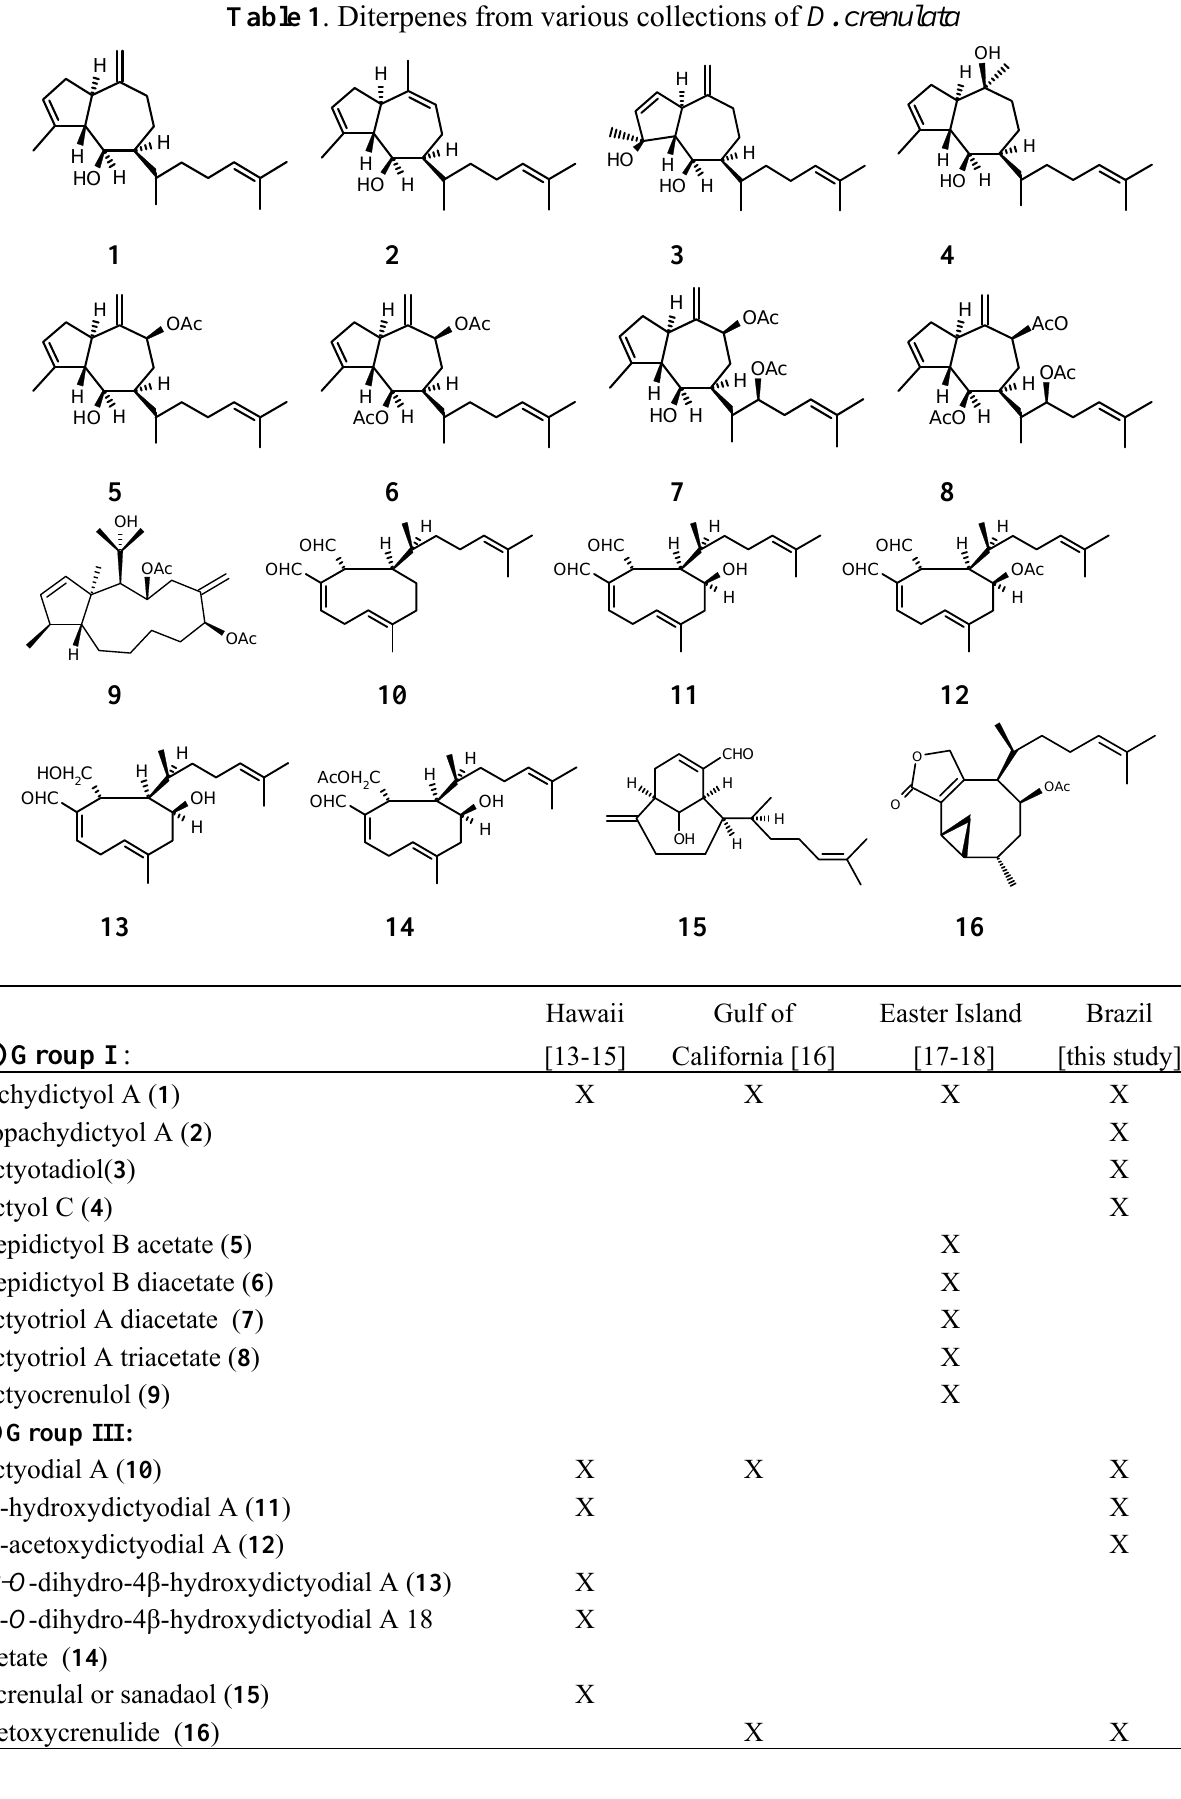
Table 1 . Diterpenes from various collections of D.